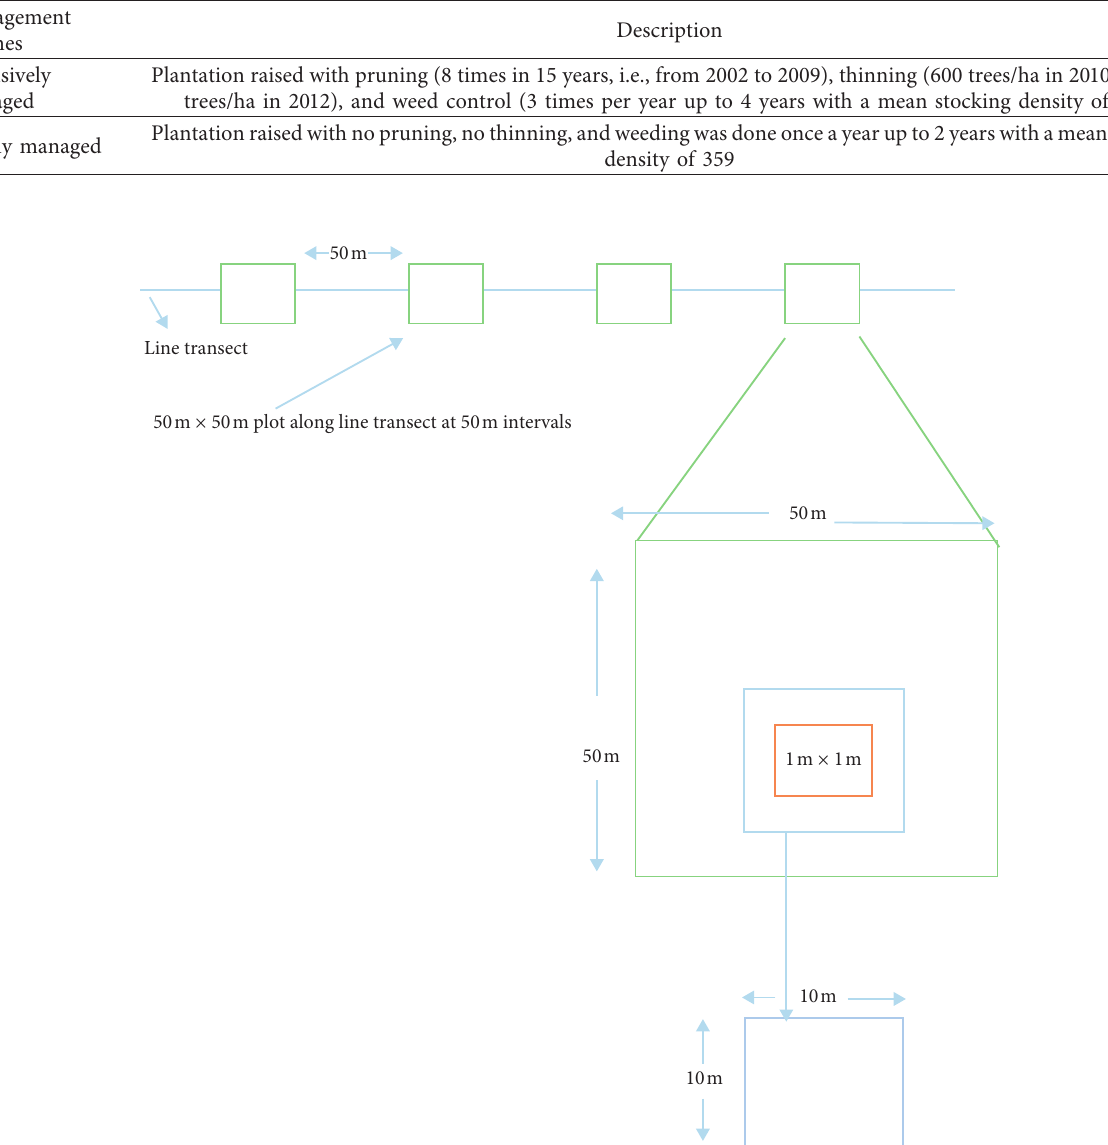
Table 1: Management regimes and their corresponding